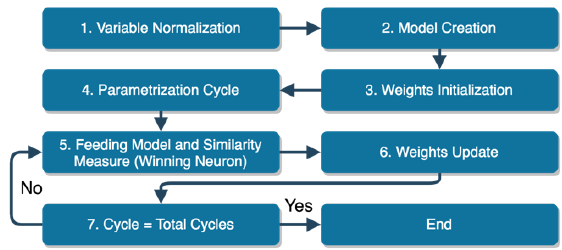
Figure 3. Network Operation of Kohonen’s SOM.